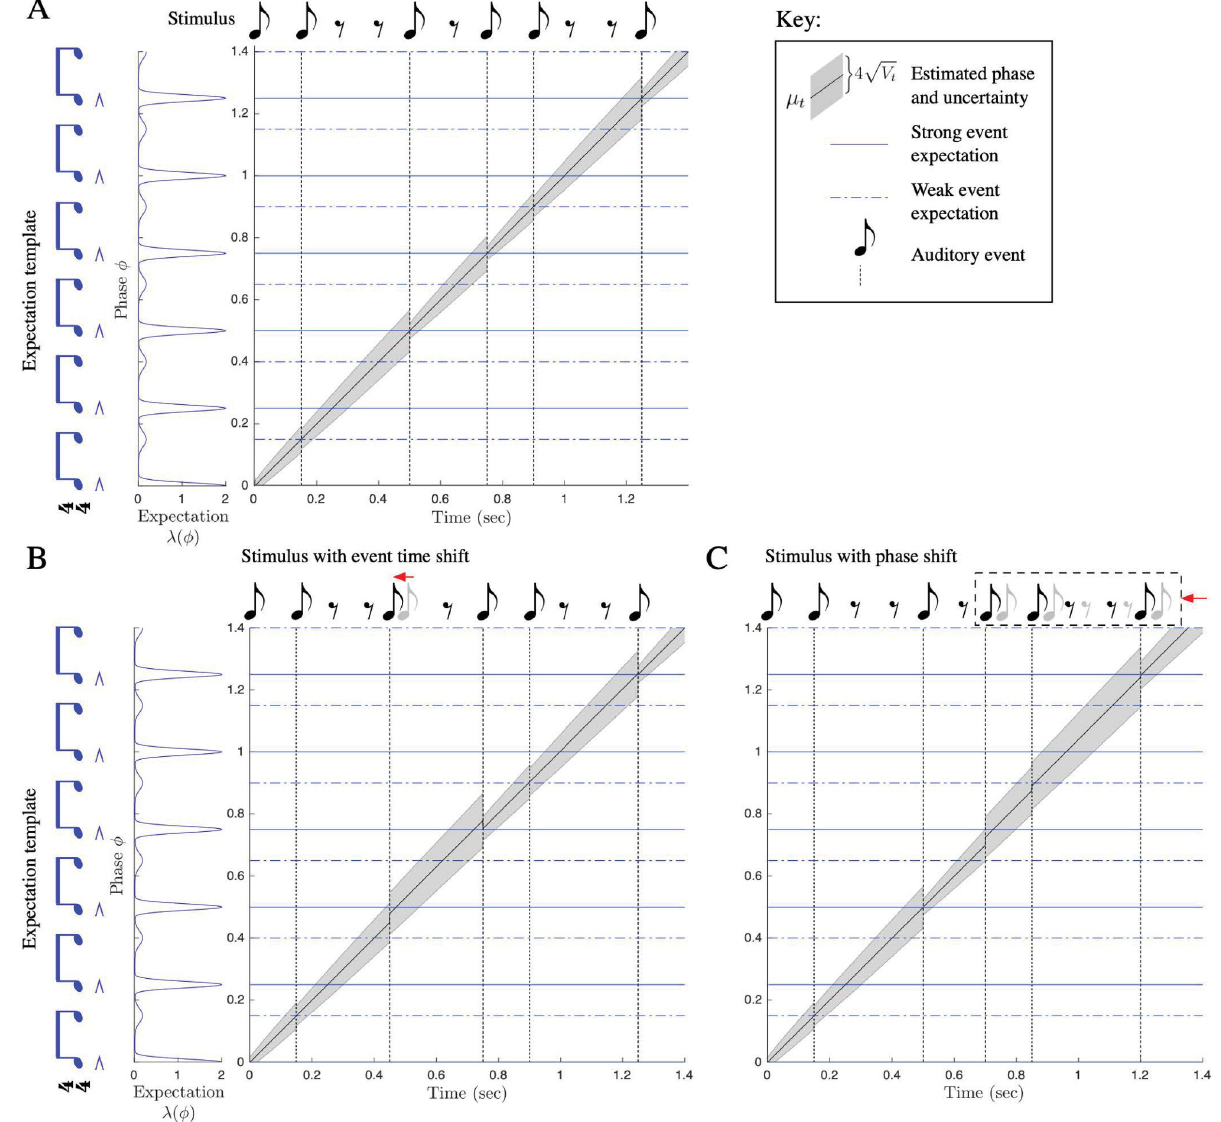
Fig 3. Tracking phase through swung rhythms. PIPPET is given a pattern of expectations representing “swung” eighth notes, with alternating longer and shorter inter-event durations and stronger, more precise expectations on the first of every pair. Dotted lines correspond to weaker expectations and solid lines correspond to stronger expectations. A) Phase is successfully tracked over the course of a rhythmic stimulus, with phase uncertainty growing between events and contracting at events. B) One event in the rhythm is shifted earlier in time. Estimated phase μ t adjusts partially to compensate for is not as effectively reined in by these unpredictably-timed events, but the timing shift, and then adjusts back at the subsequent event. Uncertainty V t decreases as later events corroborate the corrected phase estimate. C) A phase shift is introduced into the rhythm, moving all subsequent events earlier in time. When the first early event arrives, uncertainty increases. Estimated phase is corrected over the first few events after the shift, and V t decreases most substantially when the estimate μ is corroborated by a strongly expected event happening at the appropriate estimated t